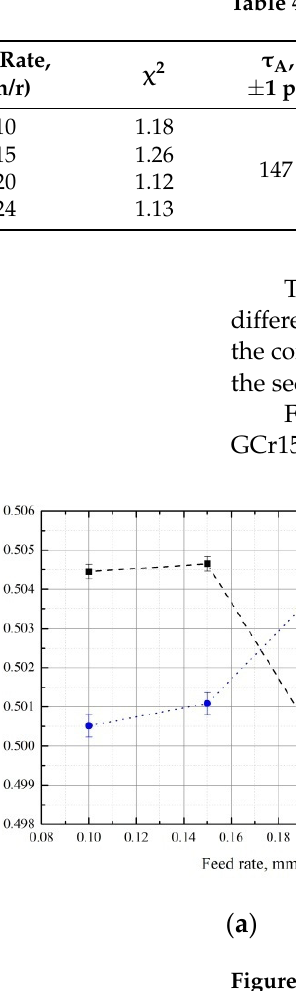
Table 4. PALS parameters of GCr15 samples depending on feed rate.